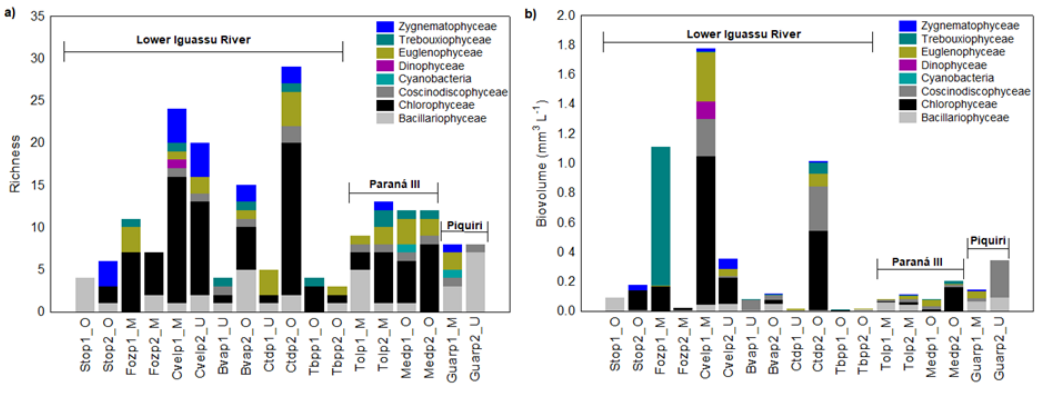
Figure 3. (a) Species richness and ( b) biovolume (mm 3 L -1 ) of phytoplankton in rivers from different hydrographic basins in western Paraná, Brazil (1- headwaters; 2 – water catchment point; O – oligotrophic; M – mesotrophic; U –